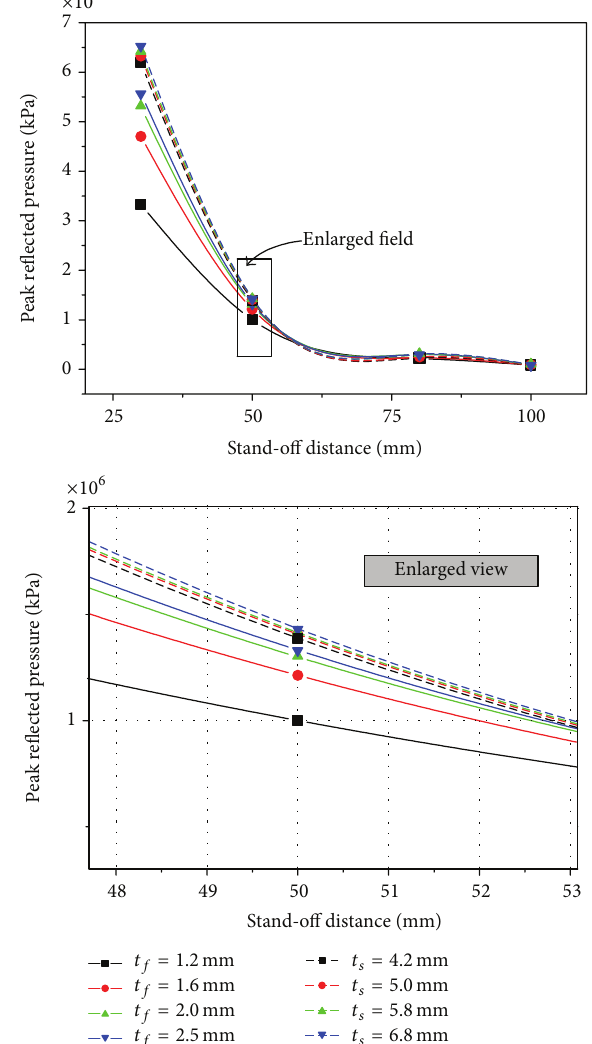
Figure 15: Comparison of the peak reflected pressure (near the FSI surface)ofsandwichpanelsandequivalentweightsolidplatesversus the stand-off distance. For sandwich panels: 𝑡 𝑐 = 1.0 mm and 𝑙 = 20